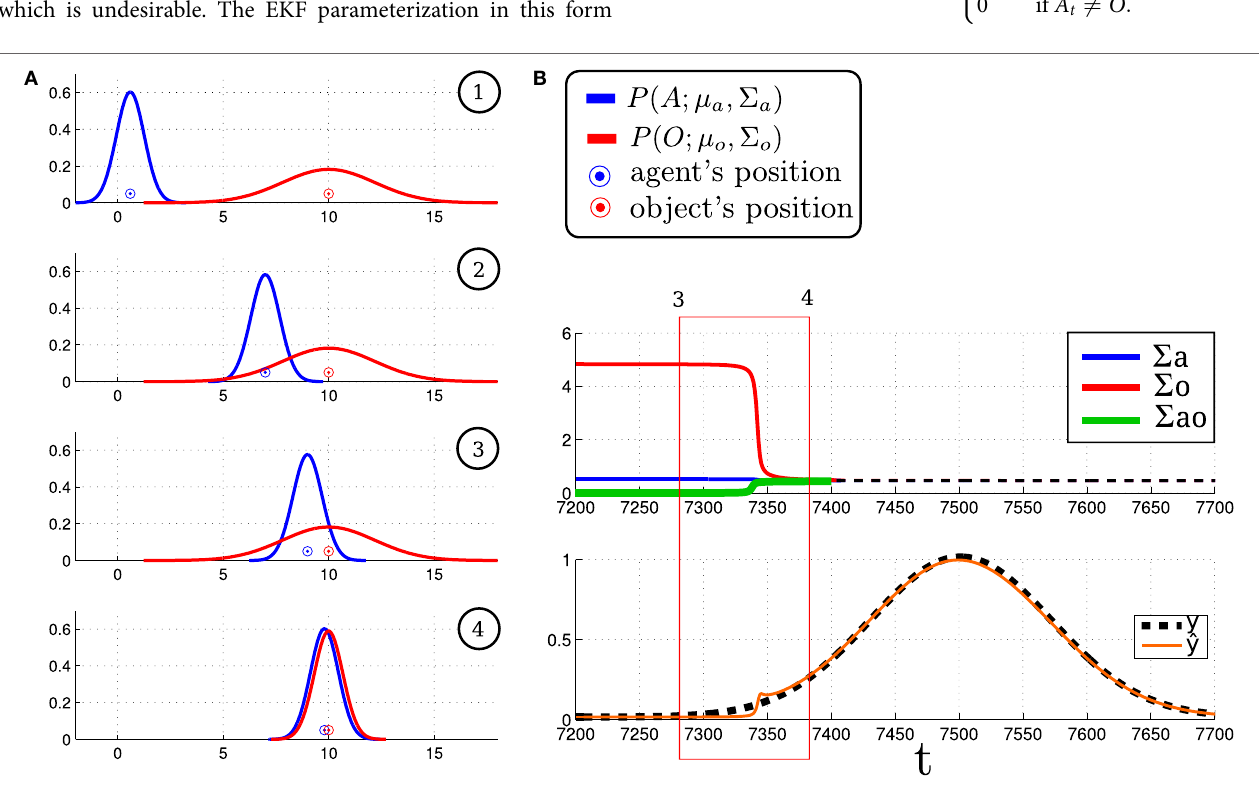
FIGURE 3 | (A) EKF-SLAM time slice evolutions of the agent and object location belief for a 1D search. The temporal ordering is given by the numbers in the top right corner of each plot. The blue pdf represents the agent’s believed location, and the circle is the agent’s true location. The same holds for the red distribution that represents the agent’s belief of the location of an object. (B) Evolution of the covariance components of (cid:6) over time and true Y t and expected measurements, ^ Y t . (cid:6) a and (cid:6) o are the variances of the agent and object positions, and (cid:6) ao is the cross-covariance term.